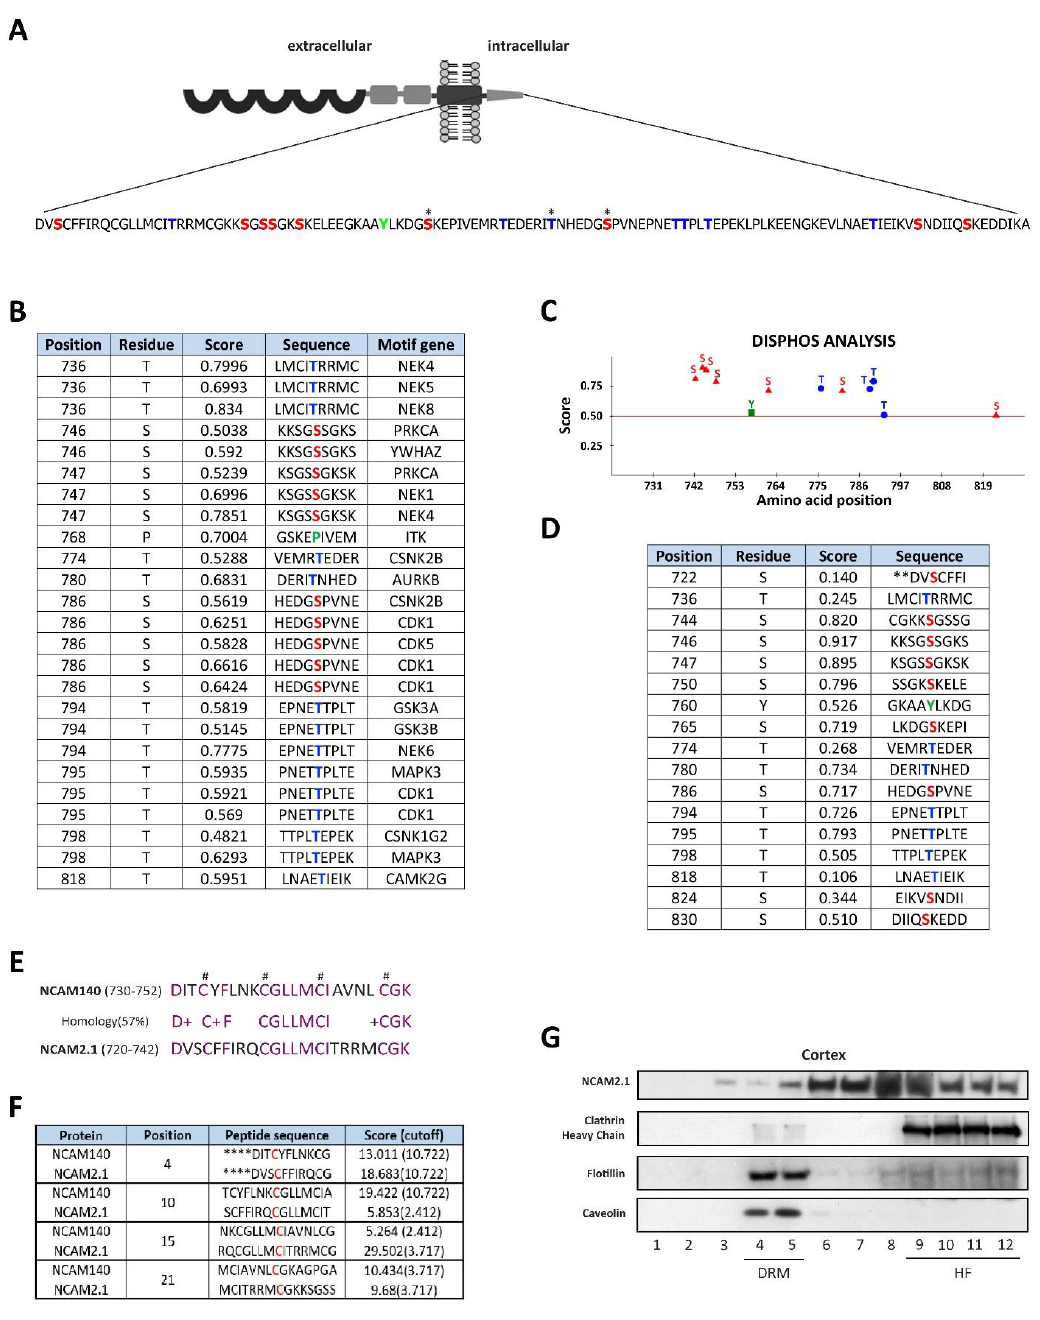
Figure 1. In silico analysis of NCAM2.1 cytoplasmatic domain. ( A ) Schematic representation of phosphorylation sites in NCAM2.1 cytoplasmatic tail amino acid sequences. Serine (red), Tyrosine (green) and Threonine (blue) phosposites are represented. * phosphorylated sites previously described. ( B ) In silico analysis using Scansite 4.0 to identify motifs gene interactors (motif gene) that are likely to be phosphorylated by specific protein kinases or binding domains such as SH2 domains, 14-3-3 domains or PDZ. ( C , D ) Schematic representation and Table of phosphorylation sites of NCAM2 cytoplasmatic tail with their in silico predicted scores using Disphos. ( E ) Comparison of NCAM140 (730–752 amino acids) and NCAM2.1 (719–741 amino acids) sequences, NCAM1 has an intracellular region with palmitoylation modification sites that contain cysteine-residues which are critical for its localization in lipid rafts and also present in NCAM2.1 cytoplasmatic domain (#). ( F ) In silico analysis of NCAM2.1 and NCAM1 with their predicted scores using CSS-Palm software 4.0. NCAM2.1 contains the same potential palmitoylation sites similarly to NCAM1 with high scores ( G ) WB of NCAM2.1 from cortical extracts subjected to sucrose gradient. NCAM2.1 co-signals in lipid rafts (lanes 4–5, DRM, Detergent-resistant membrane, identified by Flotillin and Caveolin), but mainly outside lipids rafts (lanes 6–12, HF, High